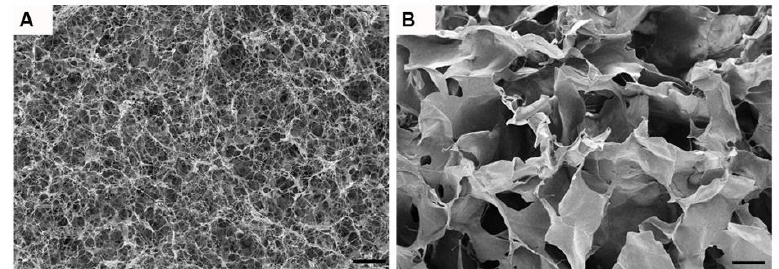
Figure 1. Pore size of the C-GAG matrix. The pore size of the dehydrothermally cross-linked C-GAG matrix was determined by SEM. ( A ) Superficial structure. ( B ) Internal structure. 200 ×. Scale bars: 50 μm.